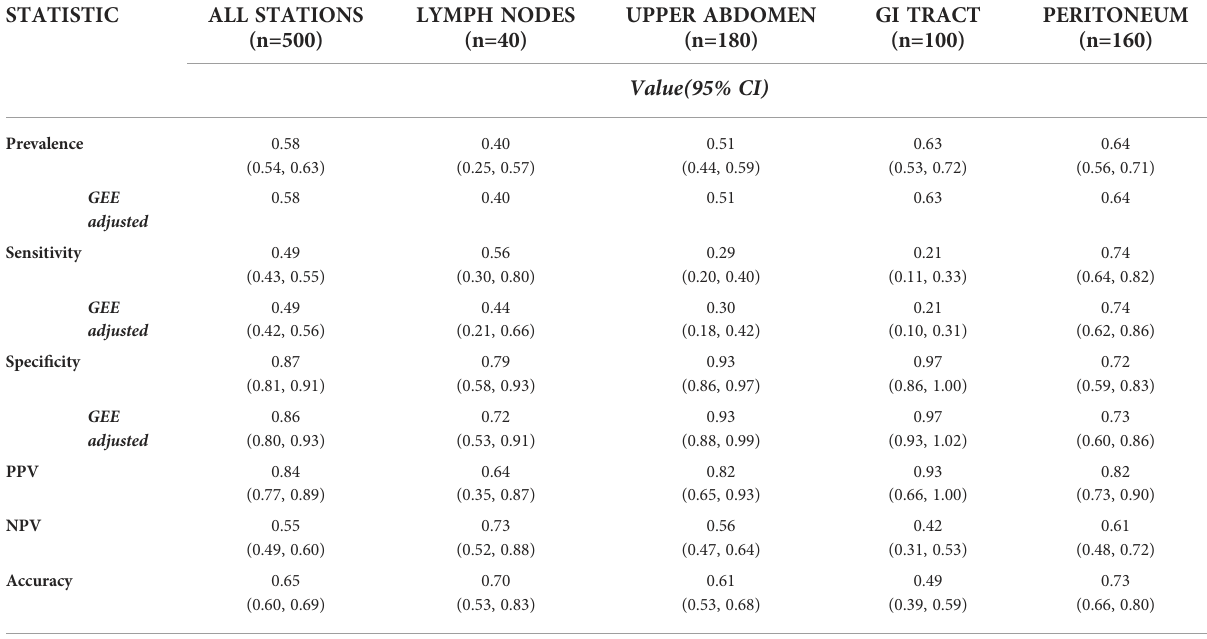
TABLE 2 Performance measures of PET with CT as the reference for all stations assessed, and for the various stations grouped by anatomic location (excluding primary tumors). STATISTIC